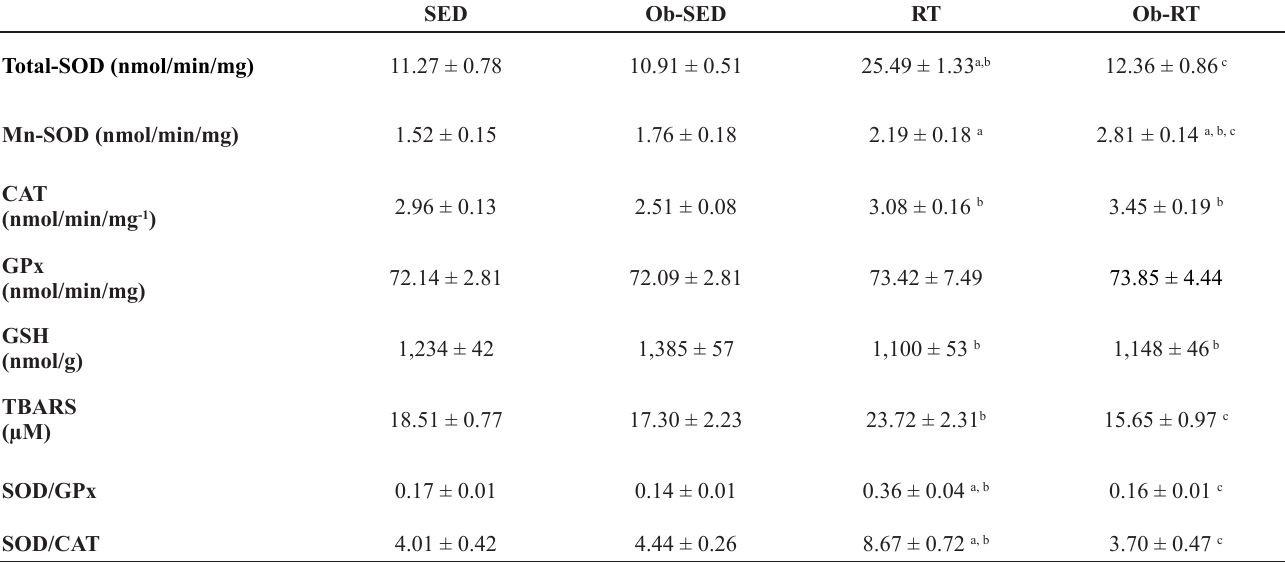
Table 3 - Biochemical assays of antioxidant activity and lipid peroxidation in the rat LV from Sedentary (SED), Obese sedentary (Ob-SED), resistance training (RT), and obese trained (Ob-RT) groups.